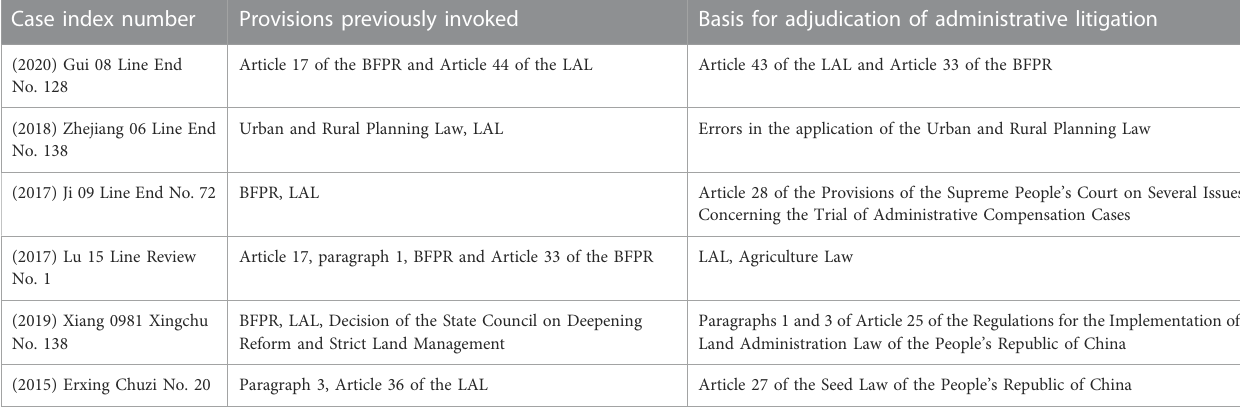
TABLE 5 Cases of administrative protection of cultivated land are scattered according to laws and